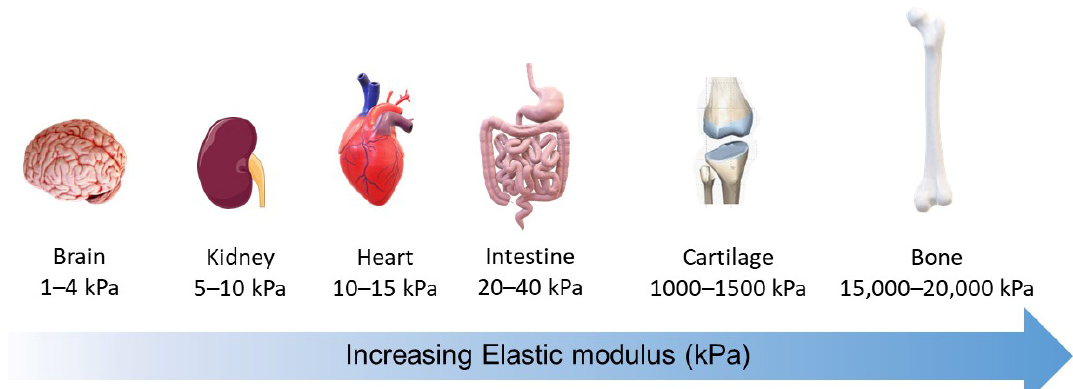
Figure 1. The stiffness of living tissues. The biomechanical properties of a tissue in terms of stiffness (elastic modulus), measured in pascals (Pa), vary between organs and tissues. Soft tissues such as the brain exhibit low stiffness, whereas tissues exposed to high mechanical loading, such as bone, exhibit elastic moduli with a stiffness that is several orders of magnitude greater. Values of Young’s modulus were from ref. [14]. The figure was created using Servier Medical Art and 3d models of Microsoft 365.